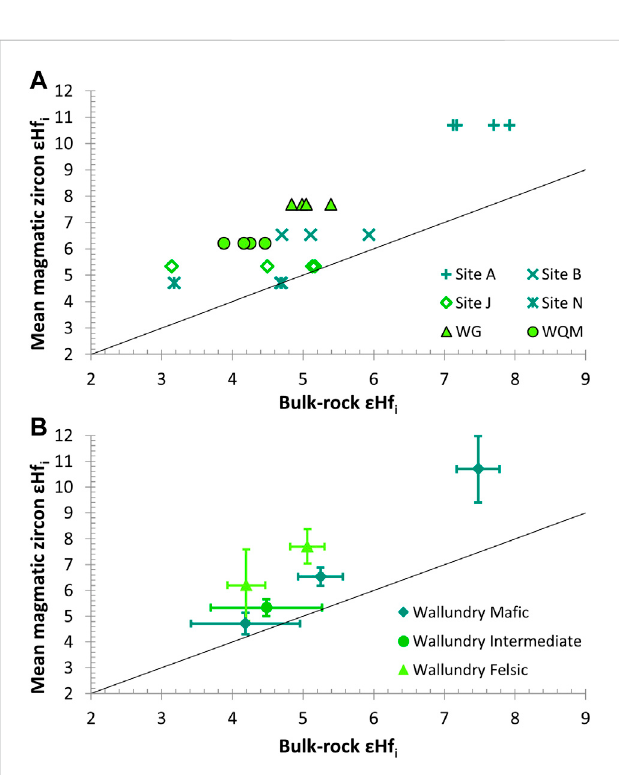
FIGURE 8 Comparison of bulk-rock and magmatic zircon Hf isotope ε Hf fi dence level uncertainty) for the Wallundry i (and 95% con